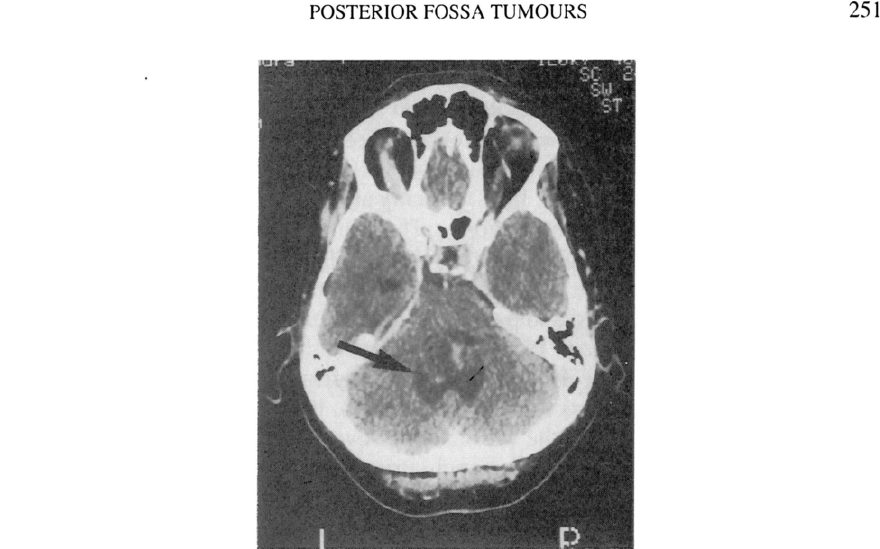
FIG. I. The photograph show the CT scan from Case 2. The arrow indicates the dilated fourth ventricle within which is a loculated mass, later found to be an